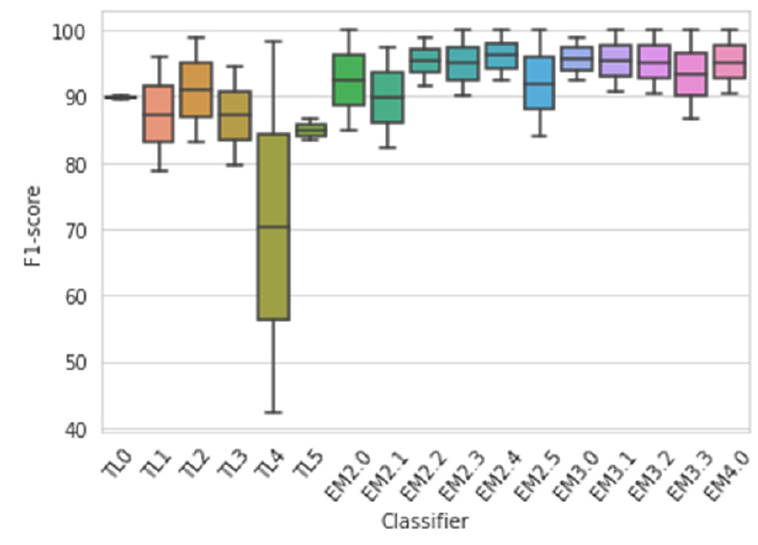
Figure 13. F1-scores of various models for both datasets taken together.